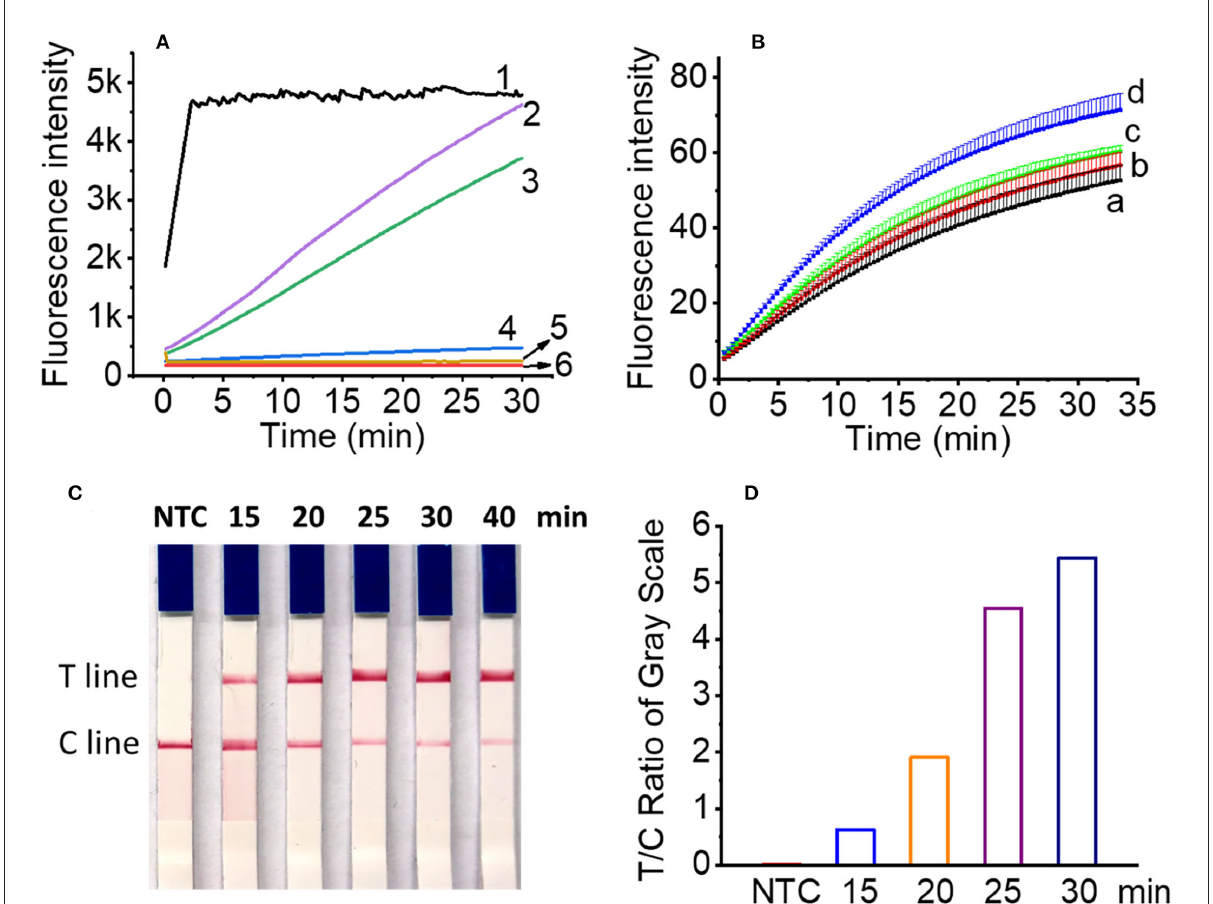
FIGURE4 Optimization of one-pot reaction condition. (A) The real time fluorescence signals of two-step (line 1), optimized one-pot detection (line 2), FQ reporter in RPA buffer (line 3), all Cas12a reagents in RPA buffer except Cas12a enzyme and NEBuffer 3.1 (line 4), crRNA/DTT/RNase inhibitor in RPA buffer (line 5) for one-pot detection and negative control (line 6). (B) The real time fluorescence signals of RPA amplicons with reaction time of 15min (line a), 20min (line b), 25min (line c), and 30min (line d), respectively. (C) Lateral flow assay results of L. maculans